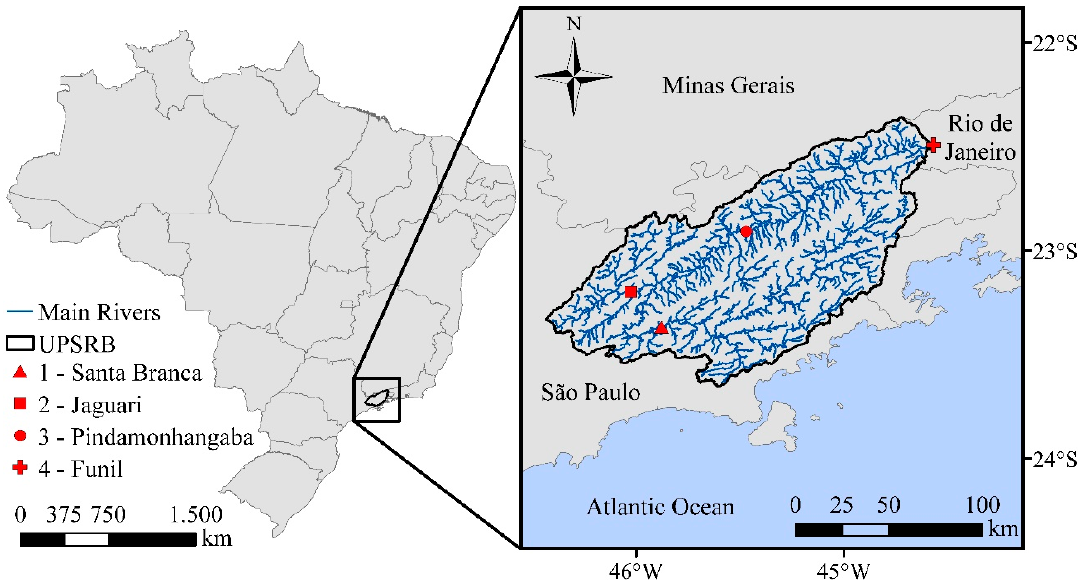
Figure 1. Cross-sections of the UPSRB.